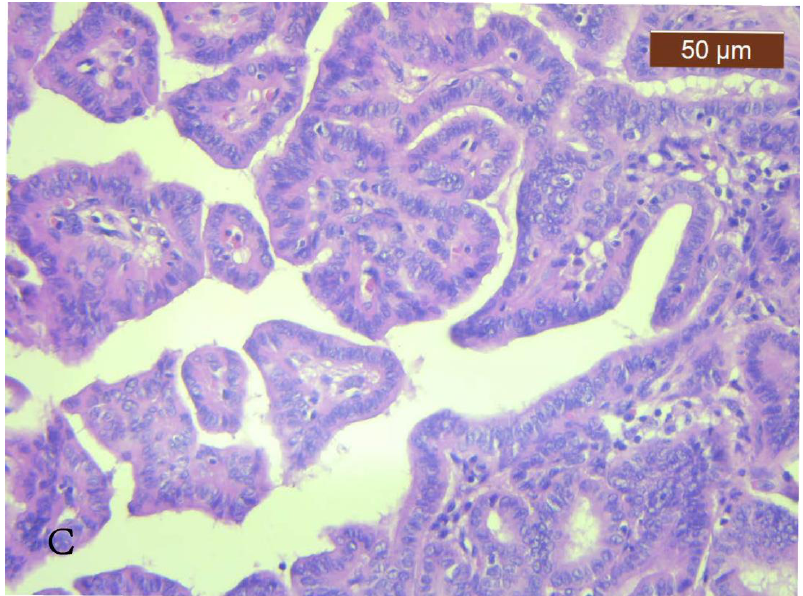
Figure 1. Collision tumor. ( A ) low power view to show a TCT comprising MTC ( upper left ) and micro-PTC ( lower right ) components in the same thyroid lobe separated by non-tumoral thyroid tissue (HE, ×25); ( B ) higher magnification of the MTC component showing a classical MTC with amyloid deposits (HE, ×200); ( C ) higher magnification of a conventional PTC component (HE, ×400).